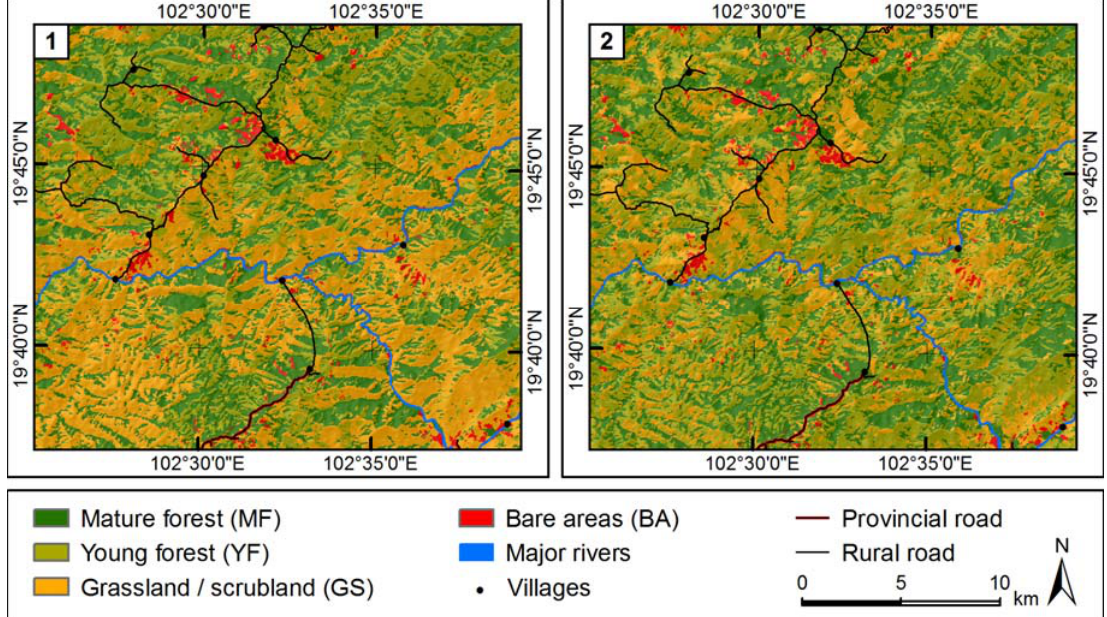
Figure 4. Comparison of the two classification approaches. On the left side, the first classification approach using ALOS AVNIR spectral reflectance and the Digital Elevation Model is shown and, on the right side, the second classification approach, which also included texture